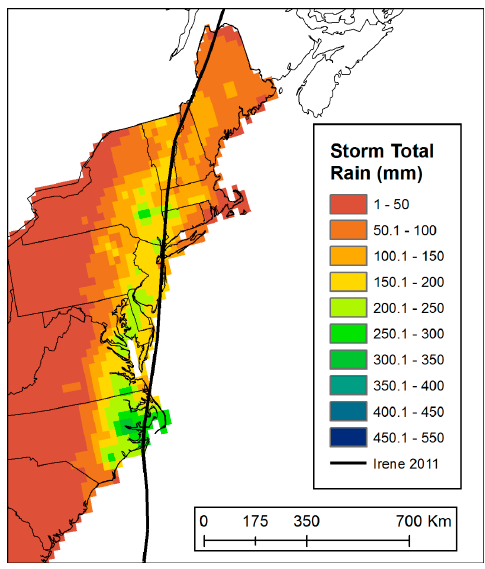
Figure 4. Storm total rainfall (mm) for Irene (2011).